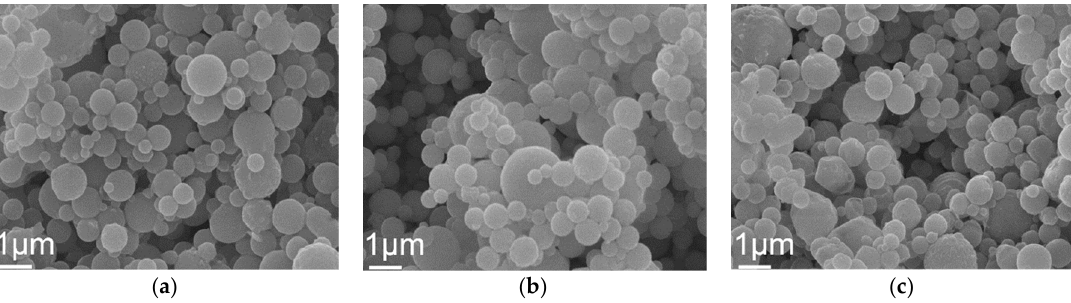
Figure 2. SEM micrographs of ( a ) pure BG powder, ( b ) YAc, and ( c ) YN derived Y-doped BG powders.